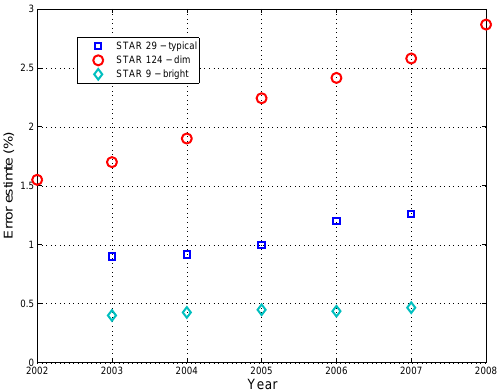
Fig. 13. Averaged error estimates for three hot stars at 50km as a function of time. Circle: Star number 9 ( M v =0.45, T = 24000K), square: Star number 29 ( M v =1.7, T = 10200K), diamond: star number 124 ( M v =2.7, T =